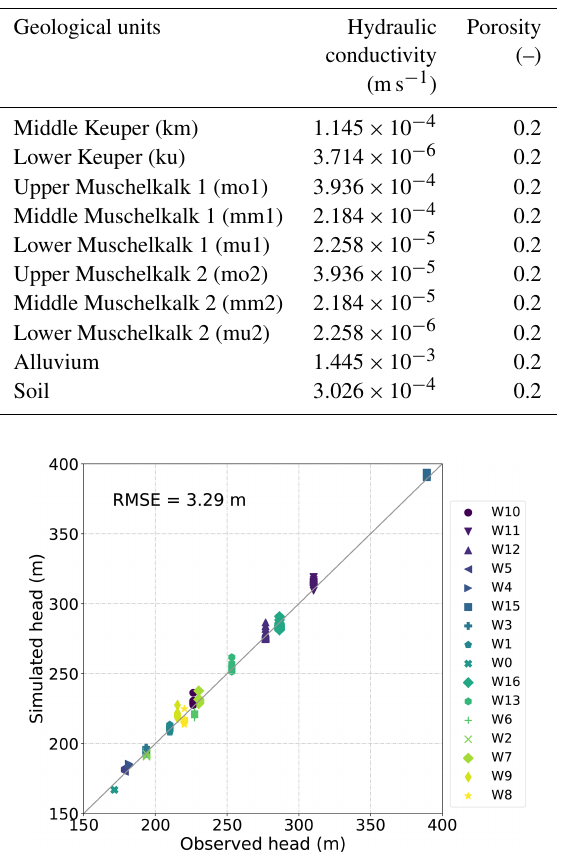
Figure 3. Groundwater model calibration: comparison of simu- lated to observed groundwater heads at several monitoring wells (W0–W16) located across the study area (Fig. 1) using 80 different hydraulic-conductivity